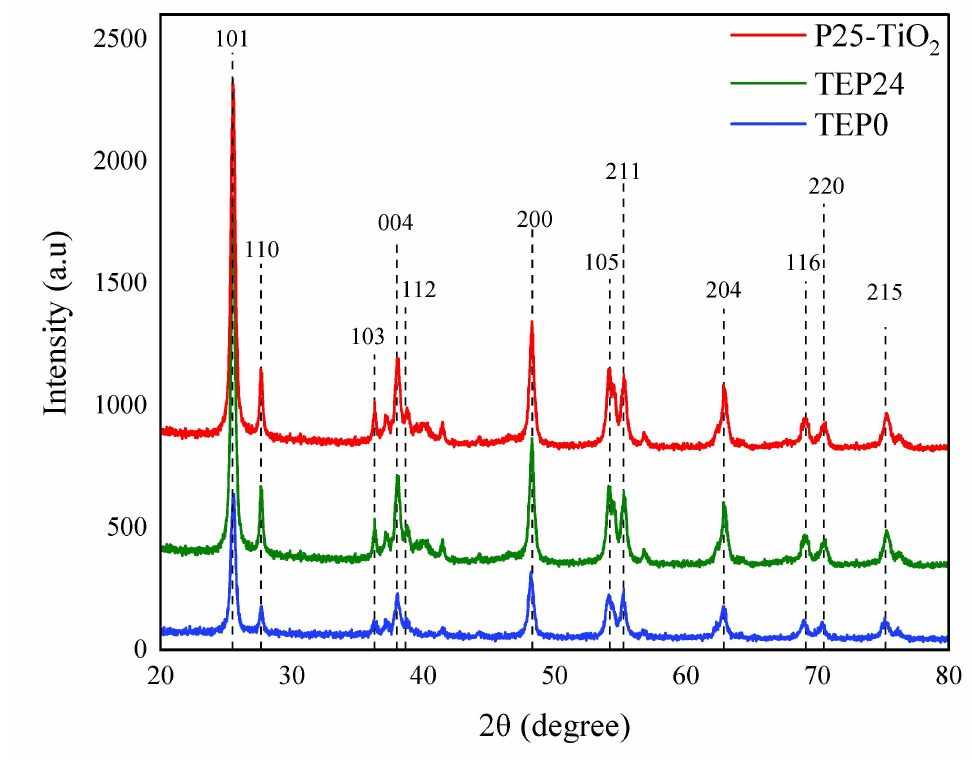
Figure 3. X-ray diffraction patterns of TEP0 and TEP24.